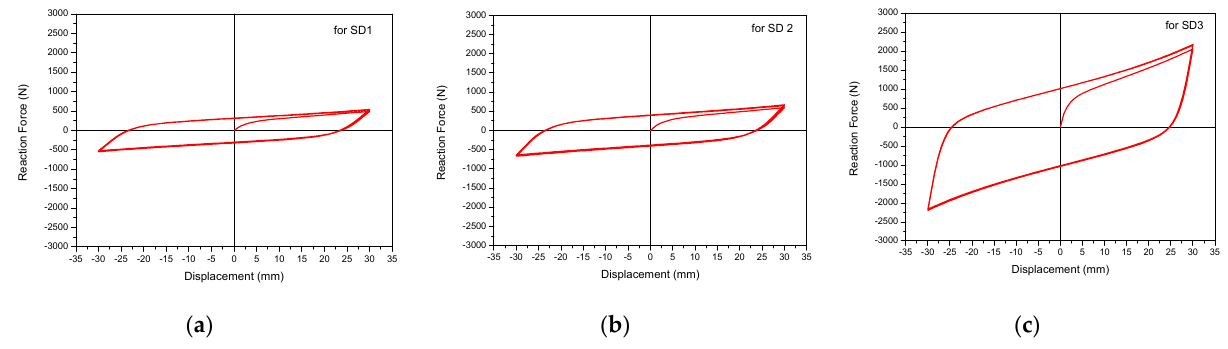
Figure 15. Analysis results of hysteretic response for steel dampers: ( a ) SD1; ( b ) SD2; ( c ) SD3.